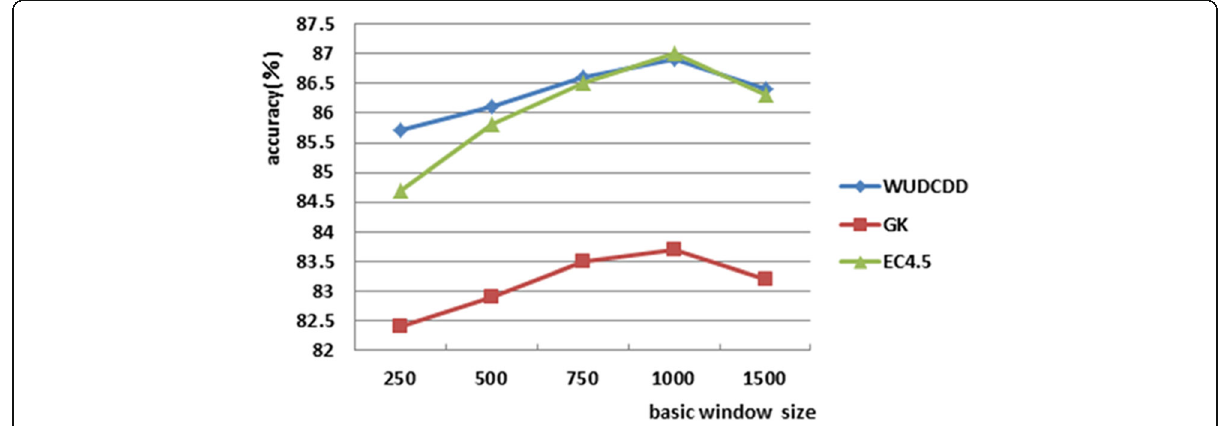
Fig. 1 Comparison of accuracy rates under different basic